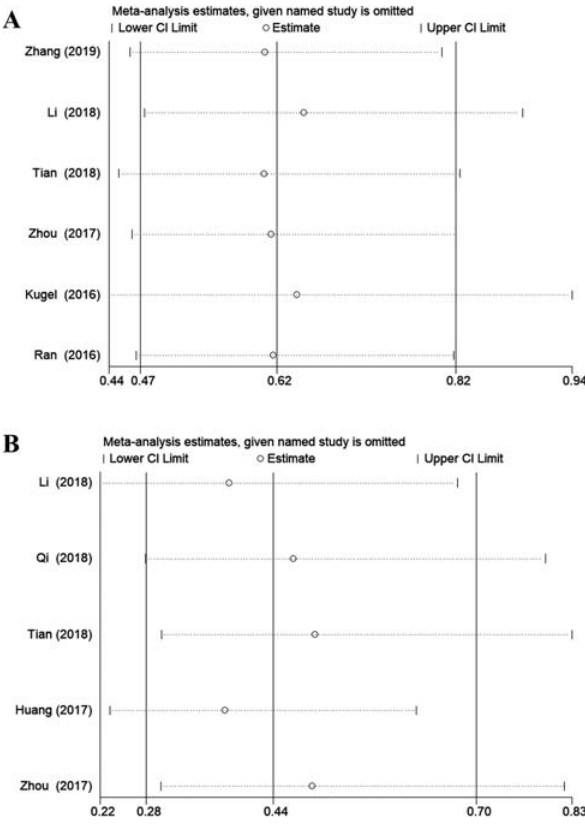
Figure 4: Sensitivity analyses of the studies: ( A ) OS and ( B ) TNM stage. Un fi lled circles: the ratio of each study; horizontal dotted line: the 95% CI of each study; solid line on the left: the lower 95% CI of the pooled results; solid line on the right: the upper 95% CI of the pooled results; and solid line in the middle: the pooled ratios of all